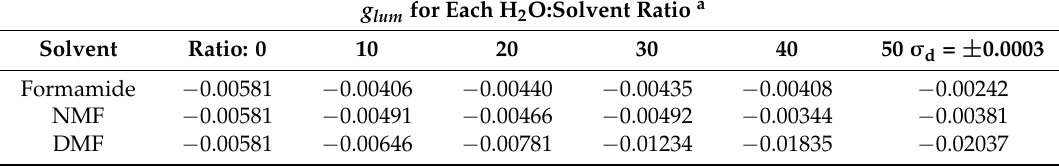
Table 2. Luminescence dissymmetry ratio values ( g lum ) in the spectral range of the 5 D 4 → 7 F 5 for 0.005 mol/L [Tb(DPA) 3 ] 3− with 40 equiv. L -serine, and varying ratios of formamide, N -methyl formamide, and N,N -dimethyl formamide.